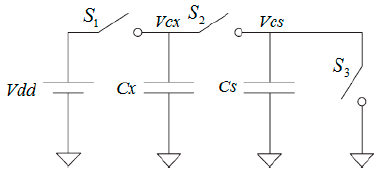
Figure 1. A simple circuit of the switch-capacitor technique.